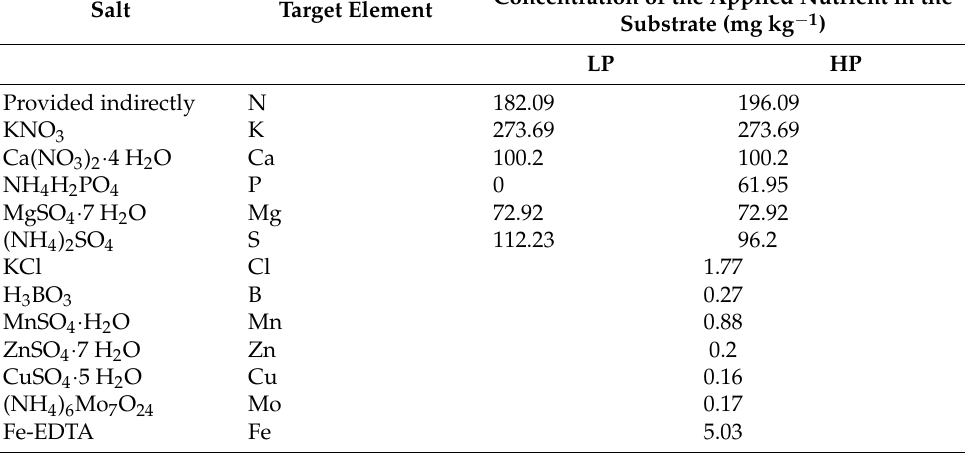
Table 2. Experiment 2. Applied nutrient concentrations of macro- and micro-elements in low-P and high-P treatments. Concentration of the Applied Nutrient in the Salt Target Element Substrate (mg kg − 1